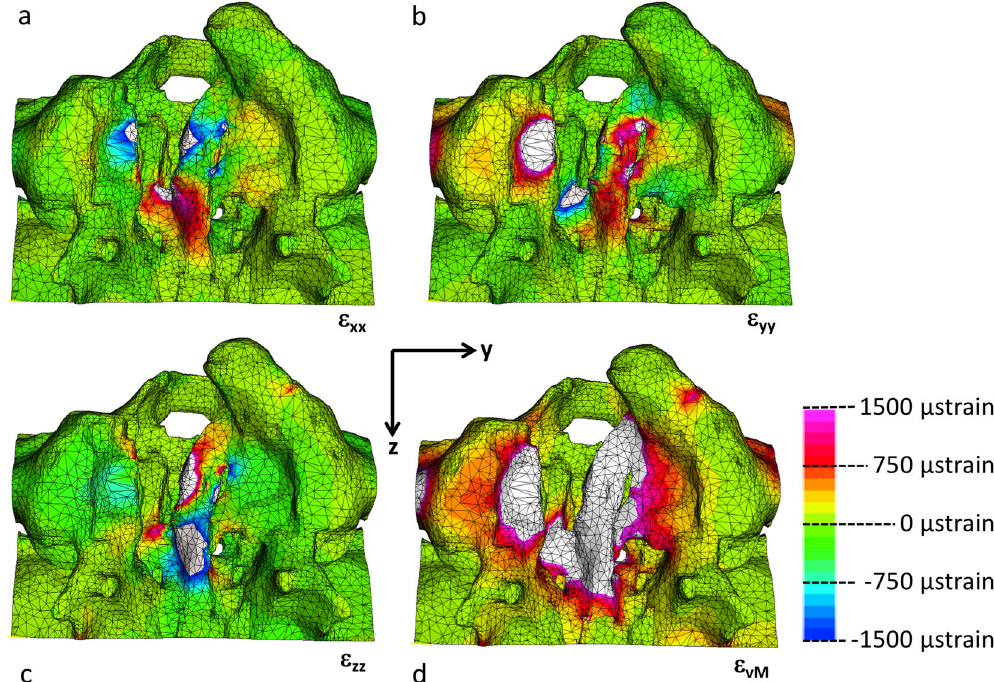
Fig. 6 The distribution of the three orthogonal strain components von Mises strains for magnetic attraction forces of 5 N a palatal view with the X-axis pointing coronally, b Y-axis pointing left, c Z-axis pointing posteriorly and d the strain intensity (von Mises